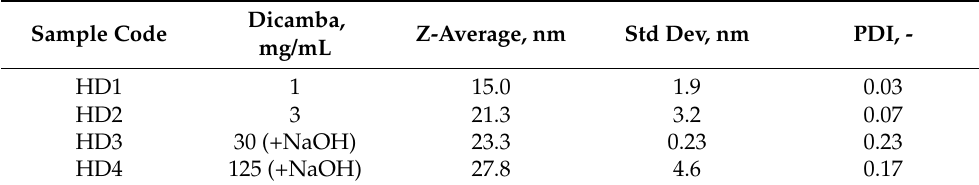
Table 4. Z-average and PDI evaluated by DLS on dicamba-loaded nanohydrogels, prepared with H2 procedure with increasing dicamba concentrations.